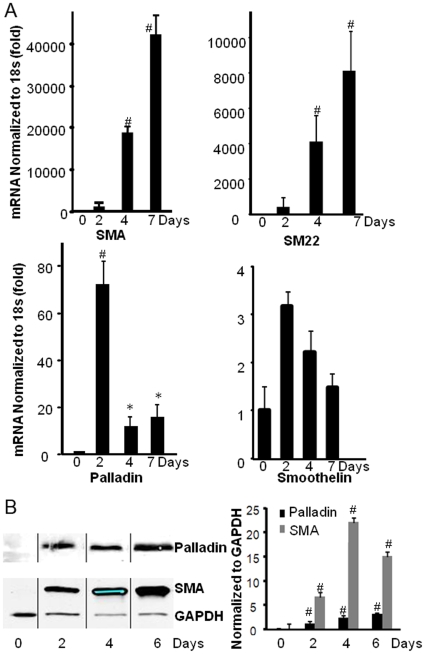
the expression of palladin, SMA, and SM22 is induced during SMC differentiation.A. Undifferentiated A404 cells were induced to differentiate into SMCs by treatment with RA (1 µmol/L). Cells were harvested at different time points, and mRNA was isolated. Palladin and SMC marker genes SMA, SM22, and smoothelin were quantified with real time RT-PCR, and normalized to ribosomal18s. Values represent the mean ±SEM of three independent experiments (n = 3). # p<0.01; * p<0.05 B. Representative Western blots show that SMA and palladin are induced at the protein level in A404 cells treated with RA. Undifferentiated subconfluent A404 cells were treated with RA, and cells were lysed with RIPA buffer at different time points. An equal amount of protein was loaded for SDS-PAGE, and blotted with anti-SMA, palladin, and GAPDH antibodies. The protein expression was normalized to GAPDH. Quantification of protein expression is showing in the bar graph. Values represent the mean ±SEM (n = 3). # p<0.01.